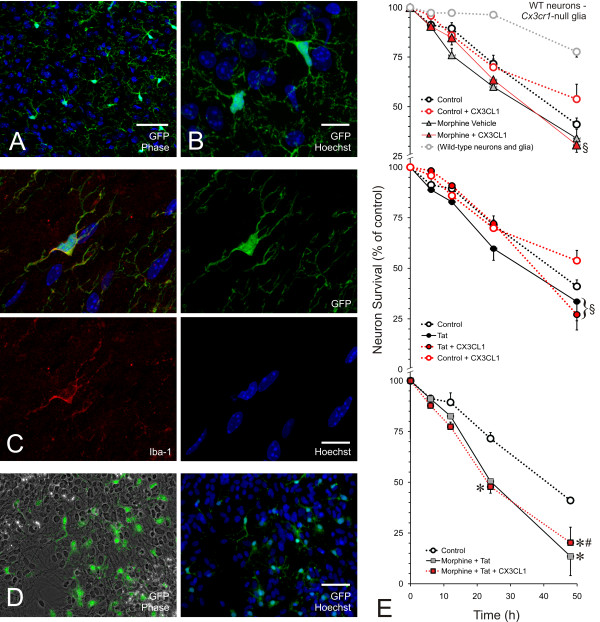
Studies with Cx3cr1-/- mice: Fluorescent images and effects of Cx3cr1-/- glia on fractalkine-mediated neuroprotection. Images of the striatum (A-C) and of mixed glial cultures (D) from Cx3cr1-/- mouse striata. Microglia within the striatum of Cx3cr1-/- (Cx3cr1GFP/GFP) mice fluoresce green (A,B) and are Iba-1 immunoreactive (C); Hoechst counterstained nuclei (blue); scale bars = 50 μm (A) and 10 μm (B,C). Robust GFP expression is maintained when the cells are placed into culture (D). As can be appreciated from the Hoechst stain, the CX3CR1-expressing population is significant although the majority of the cells in the culture lack CX3CR1. The loss of CX3CR1 on glia has a dramatic effect on the ability of fractalkine to protect morphine and Tat-treated striatal neurons (E). Neurons from the striata of wild-type mice were plated onto mixed glia prepared from Cx3cr1-/- mouse striata and followed over 48 h using our standard paradigm. In general, wild-type neurons co-cultured with Cx3cr1-/- glia appeared to be less viable than with wild-type glia (upper panel; compare gray and black dotted lines); however, these groups were not compared statistically since the experiments were not run concurrently. The neuroprotective effects of fractalkine (CX3CL1; 1 μg/ml) are abolished when wild-type neurons are co-cultured with Cx3cr1-/- mixed glia. Under these conditions, fractalkine no longer protects neurons from combined morphine and Tat exposure (E, lower panel; *P < 0.05 vs. vehicle- or fractalkine-treated controls). There were no differences in survival between controls ± fractalkine. Addition of fractalkine did not change the toxicity of morphine, Tat, or morphine + Tat treatments. There is, however, some possibility that fractalkine enhances baseline neuron survival in the Cx3cr1-/- glial co-cultures. This was indicated by significant differences only at 48 h between Tat + fractalkine versus control + fractalkine survival (§P < 0.05), even though survival did not differ when comparing vehicle + control vs. fractalkine + control or vehicle + Tat vs. fractalkine + Tat treatments. A similar inconsistency was observed only at 48 h with morphine treatments (§P < 0.05).